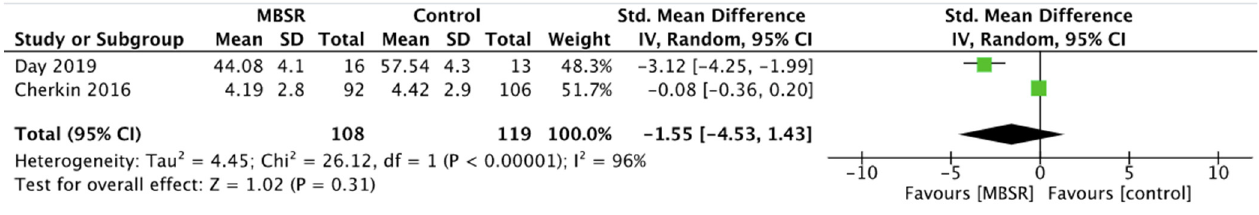
Figure 11. Depression: MBSR versus control.